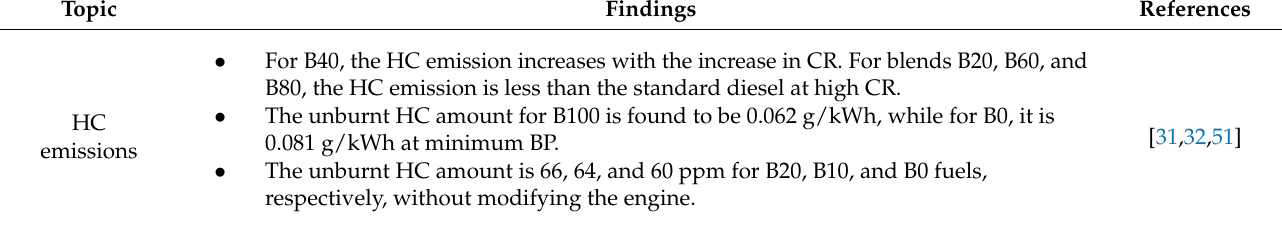
Table 5. Emission characteristics of waste cooking oil biodiesel blended with diesel fuel in diesel engines. Topic